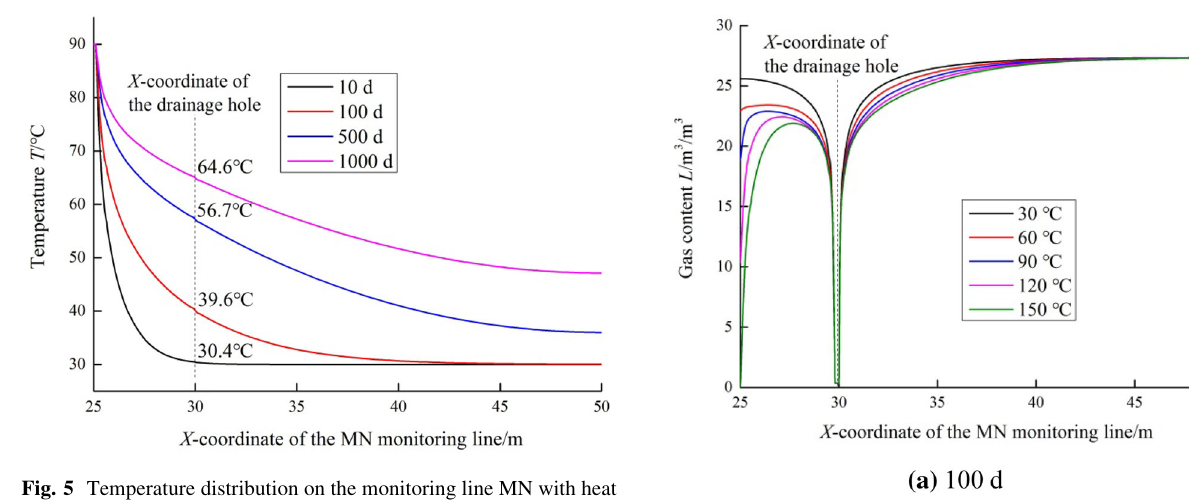
Fig. 5 Temperature distribution on the monitoring line MN with heat injection temperature T z = 90 (cid:3) C